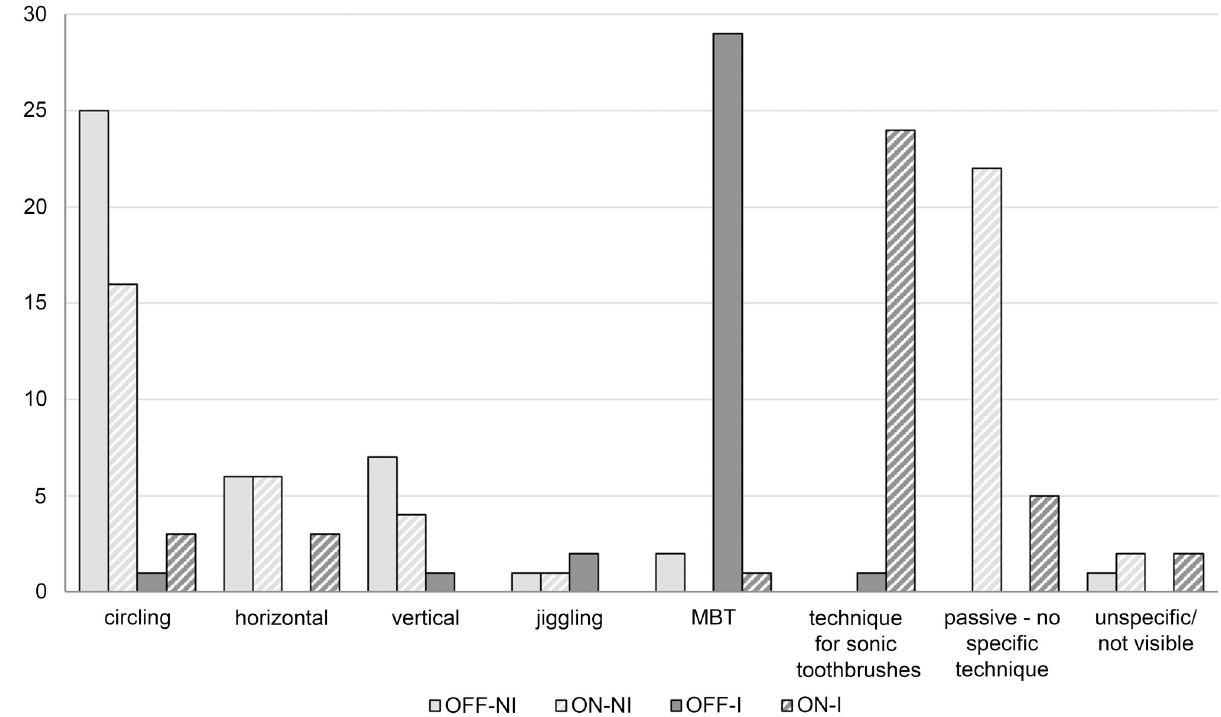
Fig 4. Occurrence of brushing movements on the buccal surfaces in the study quadrant. OFF-NI: habitual brushing using the toothbrush as a manual toothbrush; ON-NI: habitual brushing after activation of sonication; OFF-I: post instruction brushing using the toothbrush as a manual toothbrush; ON-I: post instruction brushing after activation of sonication; MBT: movements according to the Modified Bass Technique (combination of jiggling and wiping out); y-axis: number of participants showing a certain movement pattern; different types of movements can occur in one